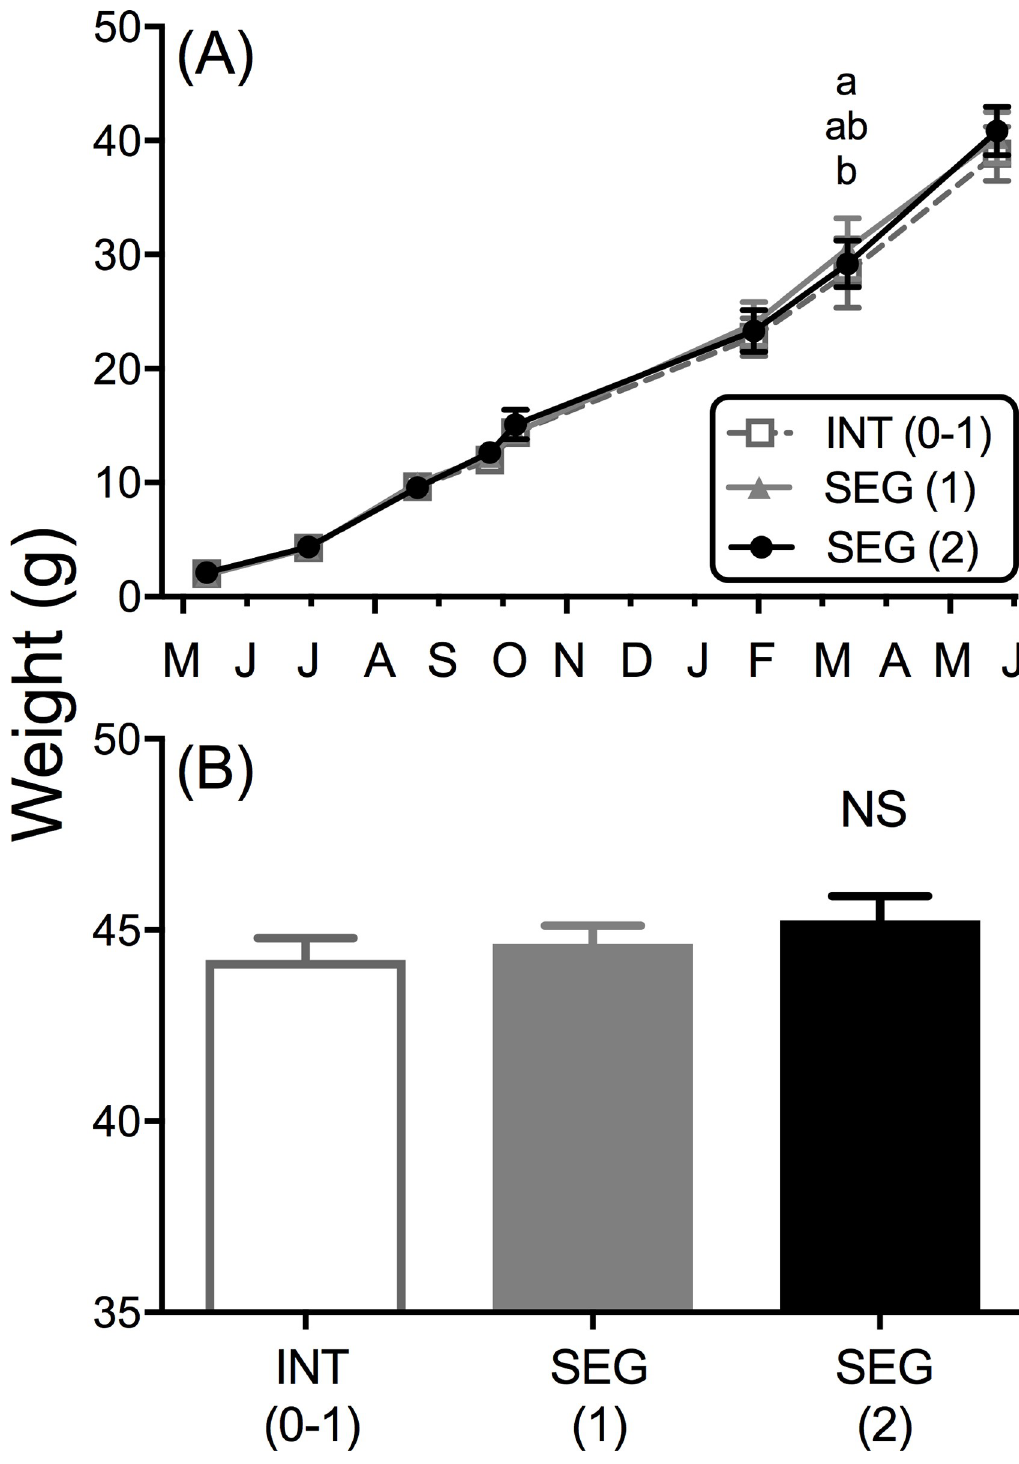
Fig 8. Growth profile comparison by broodline for common garden experiment (Part II). (A) Mean body weight (g) across dates during the experiment based on batch weights ( N ranged from 12 to 16 per treatment) for all dates except the final sample where mean weight of each tank was used as replicates ( N ranged from 3 to 4). Females are included in estimates as sex of fish was not known during batch weights. Different letters represent significant difference between broodline treatments, α = 0.05. (B) Mean adjusted body weights of individual males at completion of experiment ( N ranged from 571 to 735 per treatment). Error bars = SEM. https://doi.org/10.1371/journal.pone.0216168.g008 PLOS ONE | https://doi.org/10.1371/journal.pone.0216168 May 15,